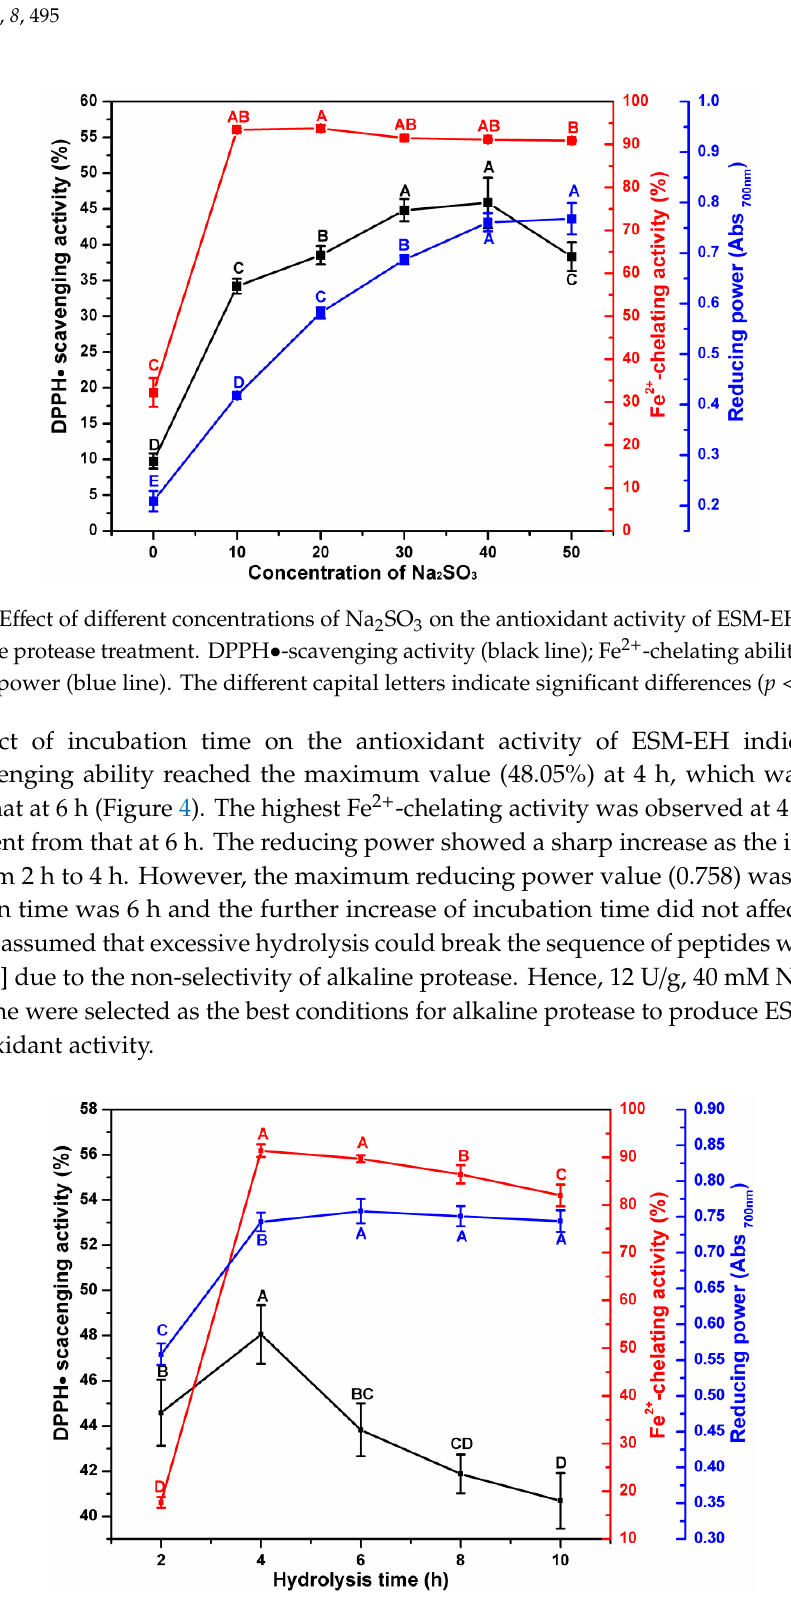
Figure 4. Effect of hydrolysis time (12 U/mg alkaline protease with 40 mM Na 2 SO 3 ) on antioxidant activity of ESM-EH. DPPH• scavenging activity (black line); Fe 2+ -chelating ability (red line); reducing power (blue line). The different capital letters indicate significant differences ( p < 0.05).